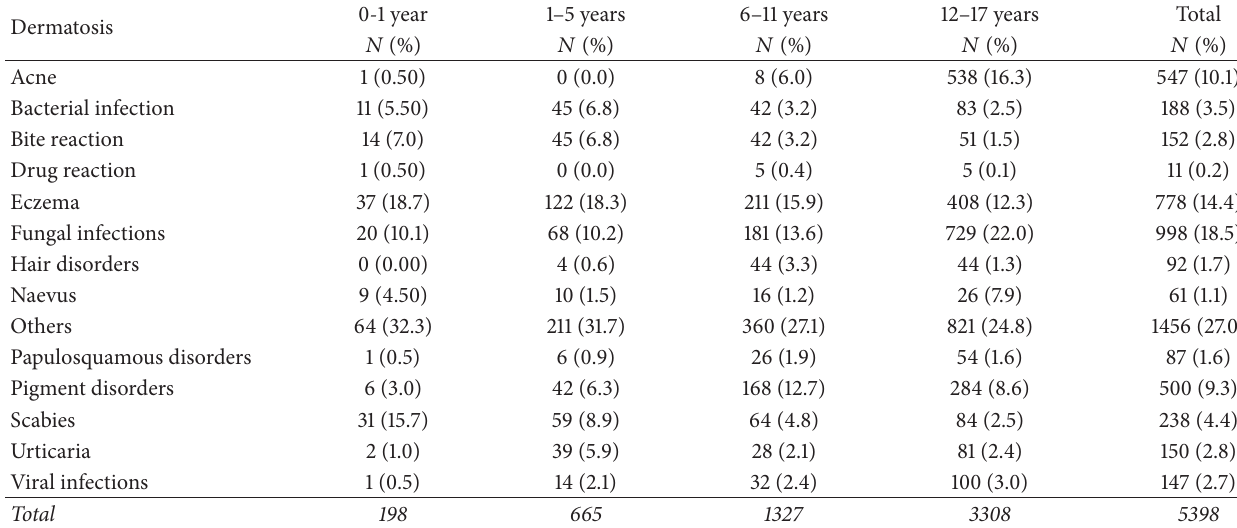
Table 1: Distribution of dermatosis according to age group.